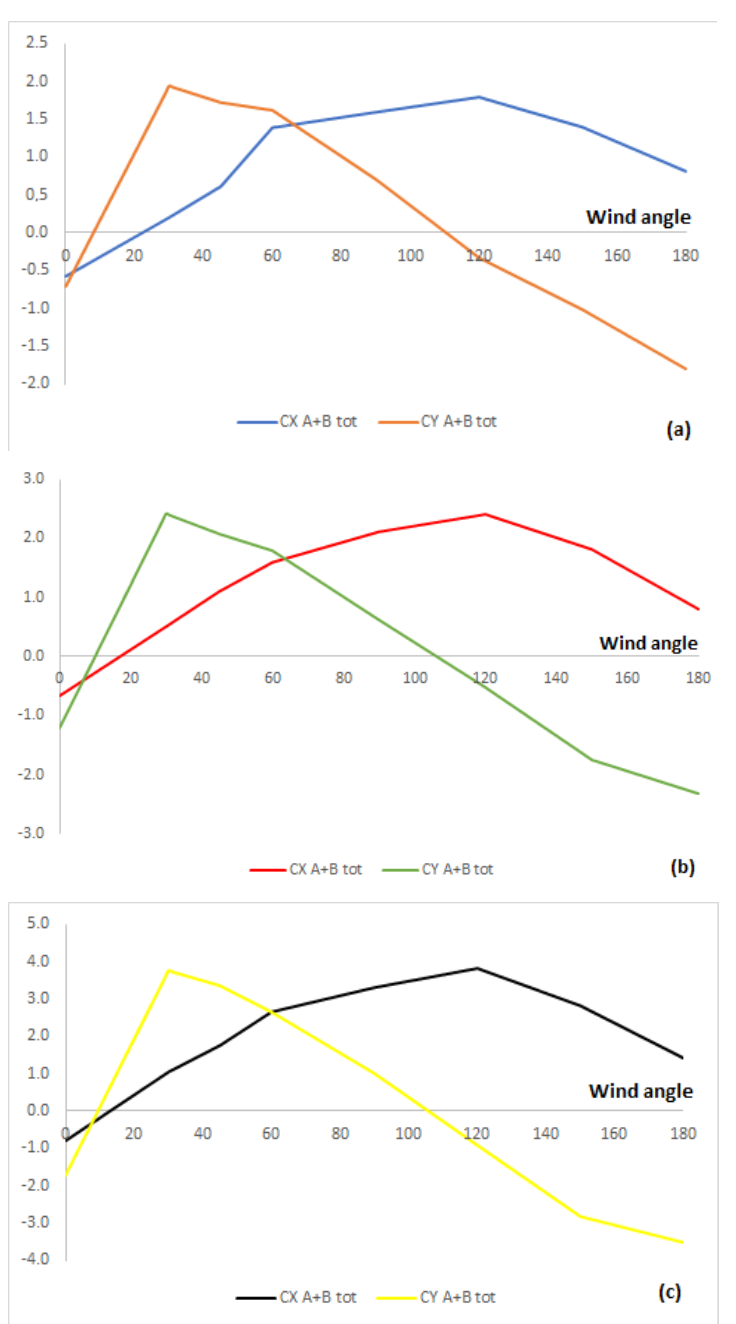
Figure 9. C X and C Y calculated from wind tunnel tests in a 15D arrangement for: ( a ) SR = 1 for both rotors; ( b ) SR = 1.5 for both rotors; ( c ) SR = 2 for both rotors.